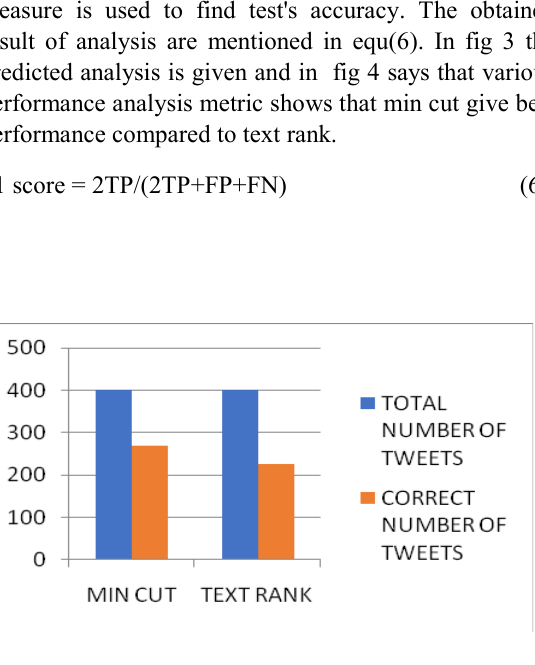
Fig. 3. Predicted analysis for min-cut and text rank